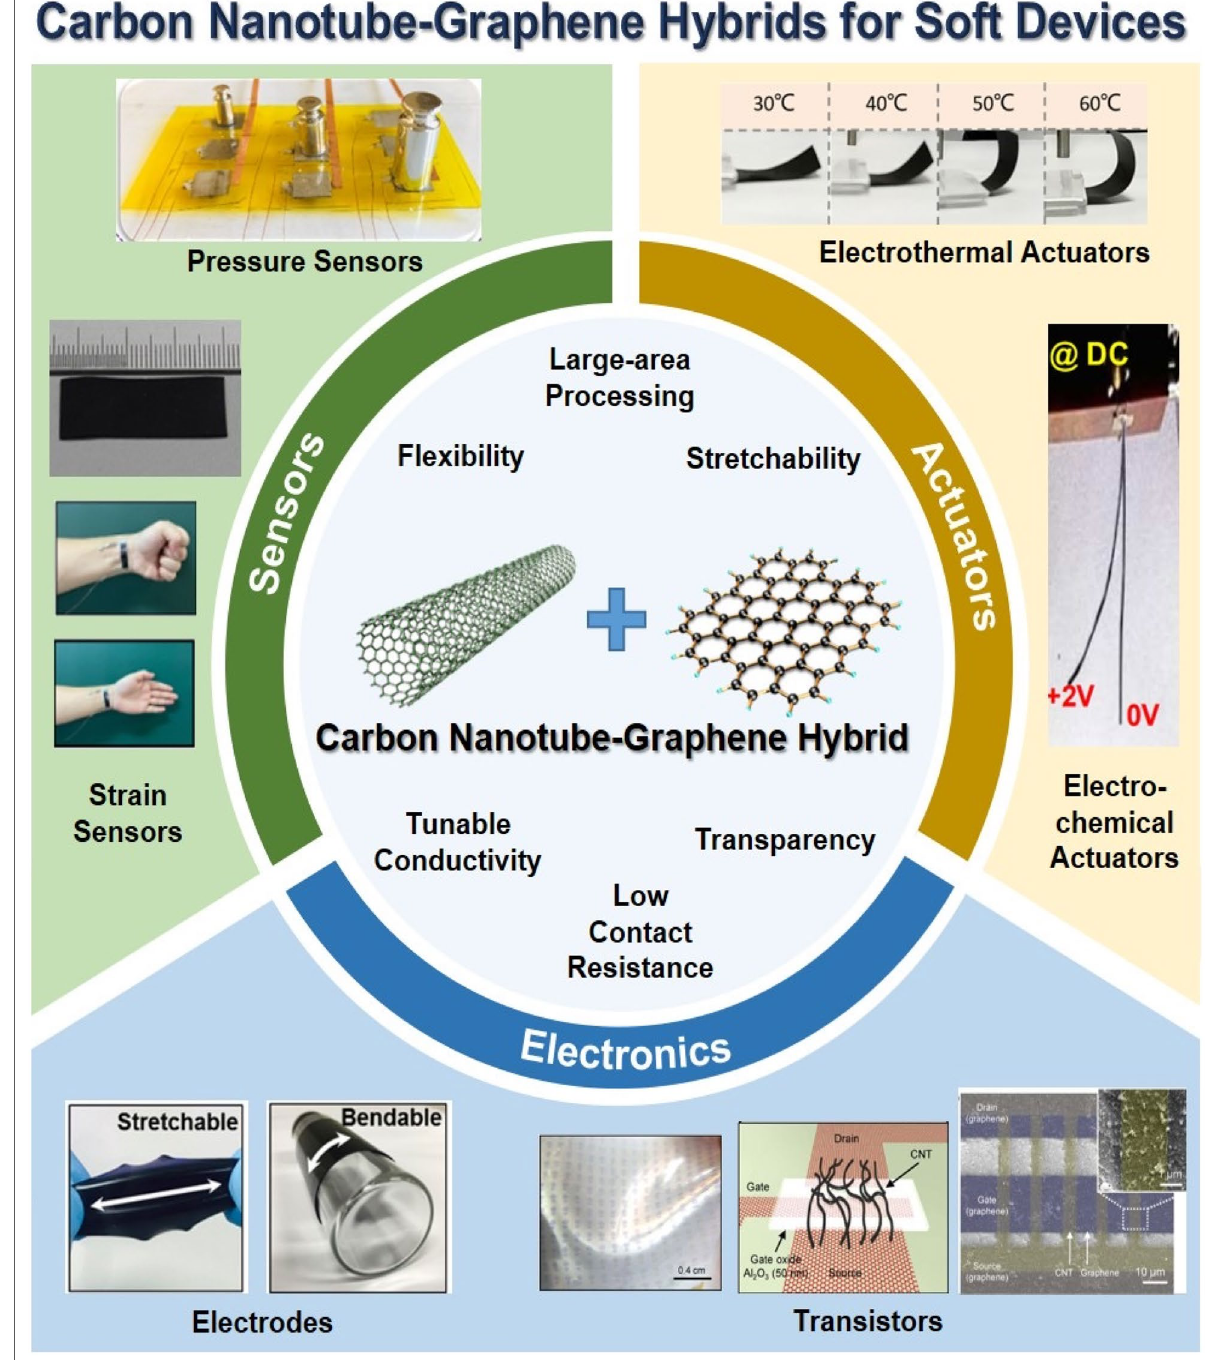
Fig. 1 Applications of carbon nanotube (CNT)-graphene hybrids for soft electronics, sensors, and actuators. Superior properties and characteristics of multidimensional hybrid carbon nanomaterials significantly improve the performance of soft devices. Pressure sensors: Reproduced with permission [27]. Copyright 2021, Elsevier B.V. Strain sensors: Reproduced with permission [28]. Copyright 2021, American Chemical Society. Electrothermal actuators: Reproduced with permission [29]. Copyright 2018, American Chemical Society. Electrochemical actuators: Reproduced with permission [30]. Copyright 2017, John Wiley and Sons. Electrodes: Reproduced with permission [31]. Copyright 2016, American Chemical Society. Transistors: Reproduced with permission [21]. Copyright 2011, American Chemical